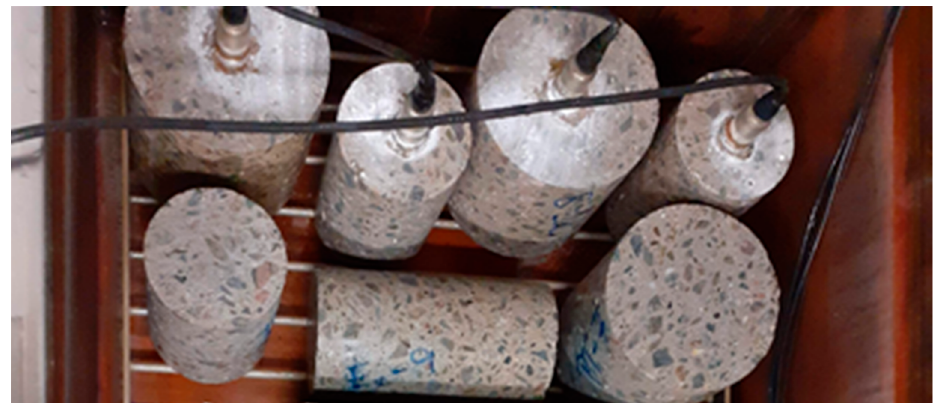
Figure 1. Arrangement of the test specimens with AE sensors in the KD 20 equipment during F-T cycles.